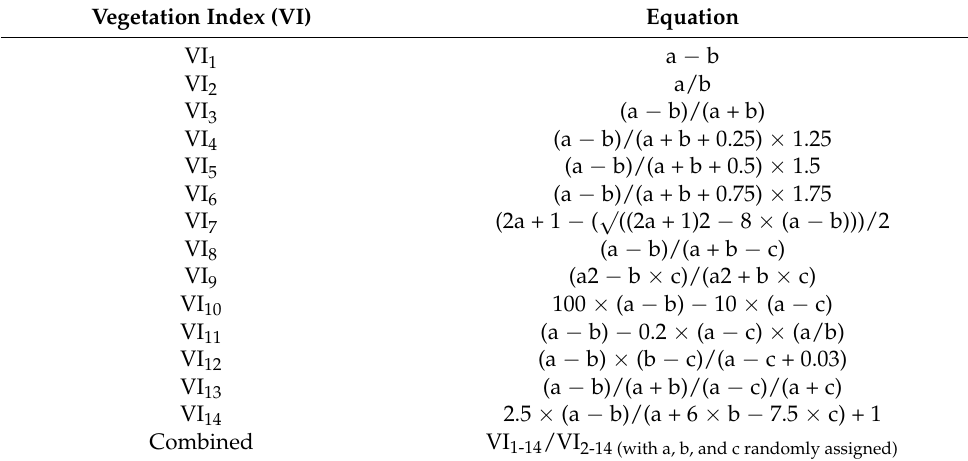
Table 3. Vegetation indices for a combination of a, b, and